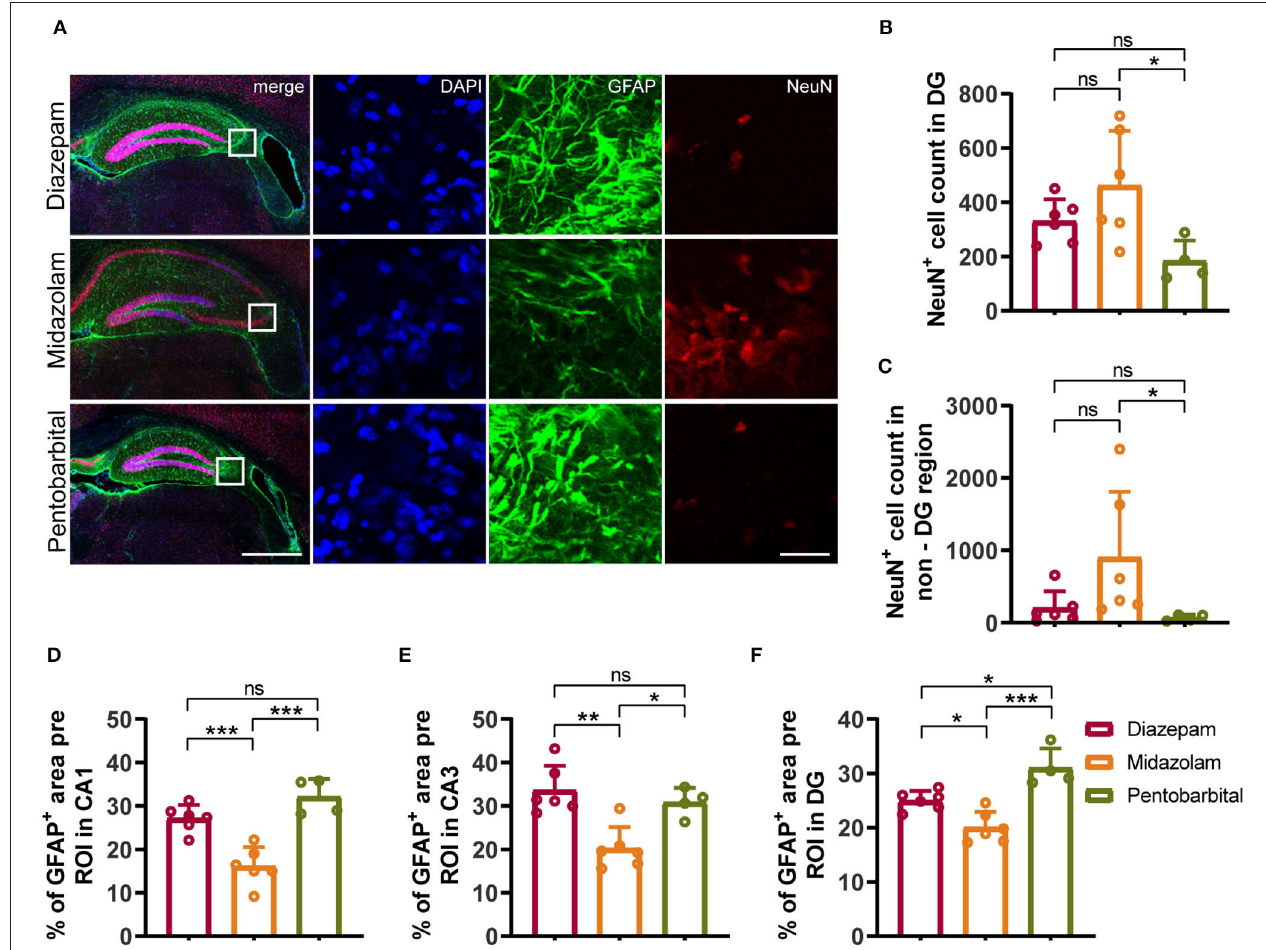
FIGURE 4 | Immunohistochemical staining showed differential hippocampal neuronal loss and astrogliosis 9 weeks after SE received different treatments. (A) Representative staining for neurons (NeuN + ) and astrocytes (GFAP + ) of diazepam, midazolam and pentobarbital groups. Left scale bar: 500 µ m; right scale bar: 100 µ m. (B) Statistics of NeuN + cell count in hippocampal DG area (diazepam, n = 6; midazolam, n = 6; pentobarbital, n = 4). (C) Statistics of NeuN + cell count in hippocampal non-DG area (diazepam, n = 6; midazolam, n = 6; pentobarbital, n = 4). (D) Statistics of percentage of GFAP + area per region of interest (ROI) in hippocampal CA1 area (diazepam, n = 6; midazolam, n = 6; pentobarbital, n = 4). (E) Statistics of percentage of GFAP + area per region of interest (ROI) in hippocampal CA3 area (diazepam, n = 6; midazolam, n = 6; pentobarbital, n = 4). (F) Statistics of percentage of GFAP + area per region of interest (ROI) in hippocampal DG area (diazepam, n = 6; midazolam, n = 6; pentobarbital, n = 4). One-way ANOVA with post-hoc Tukey’s multiple comparisons test, * p < 0.05, ** p < 0.01, *** p < 0.001, ns indicates no significant difference. Data were presented as mean ±